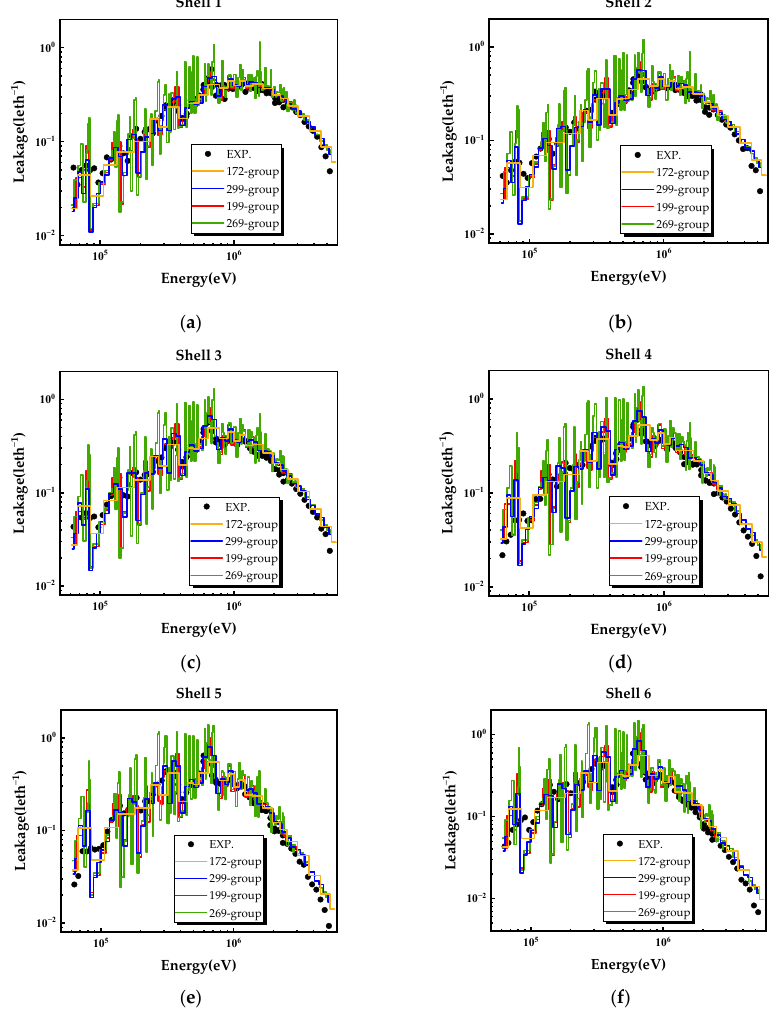
Figure 10. Cf-252 source neutron leakage spectra of iron spheres with six different thicknesses. ( a ) Shell 1: thickness 6.476 cm. ( b ) Shell 2: thickness 8.976 cm. ( c ) Shell 3: thickness 11.476 cm. ( d ) Shell 4: thickness 13.976 cm. ( e ) Shell 5: thickness 16.476 cm. ( f ) Shell 6: thickness 18.976